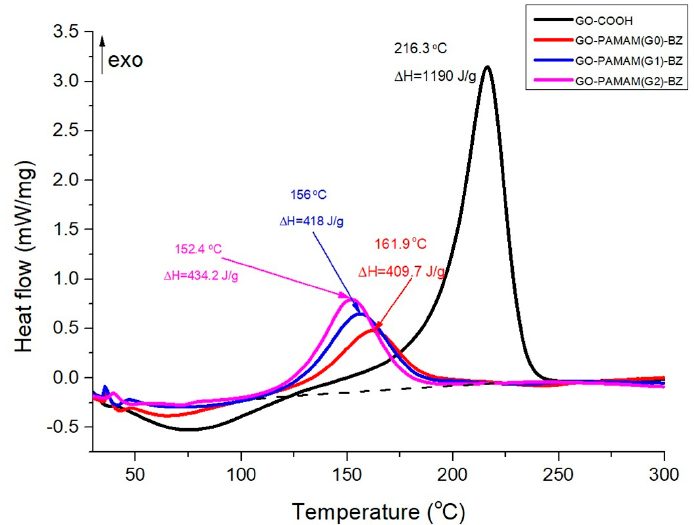
Figure 12. DSC curves for GO-COOH and final benzoxazine functionalized products.